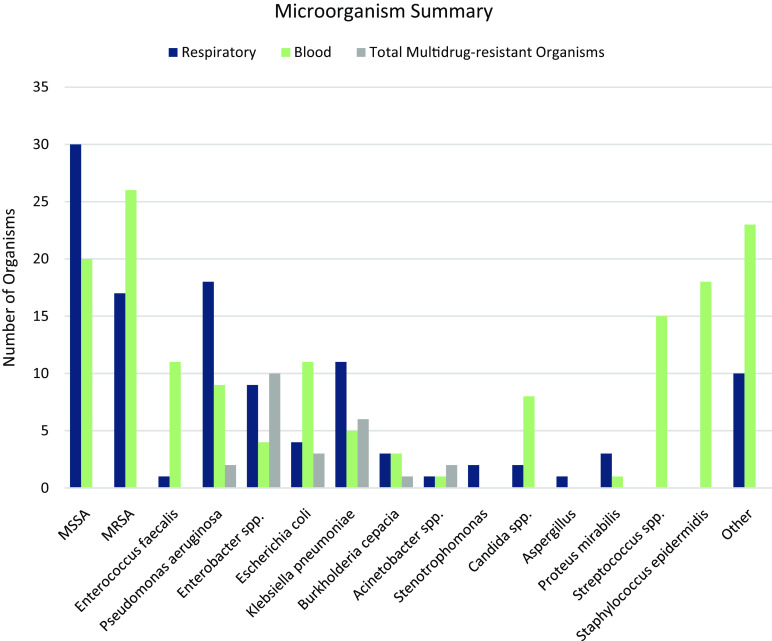
Microorganism summary. Note. *Abbreviations: MSSA, Methicillin-sensitive Staphylococcus aureus; MRSA, Methicillin-resistant Staphylococcus aureus; spp., species Other microorganisms include: Stenotrophomonas maltophilia, Serratia marcescens, Actinomyces neuii, Corynebacterium afermentans, Corynebacterium matruchotii, Rothia mucilaginosa, Elizabethkingia meningoseptica, Blautia coccoides, Escheria vulneris, Prevotella disiens, Fusobacterium necrophorum, Bacteroides ovatus group, Bacteroides thetaiotaomicron, Fusobacterium nucleatum, Achromobacter xylosoxidans, Chryseobacterium gleum, Citrobacter koseri, Haemophilus parainfluenzae, Serratia marcescens